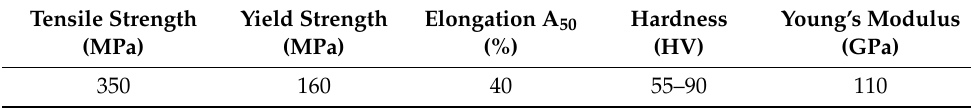
Table 1. Prescribed mechanical properties of brass cone pipe (CuZn 3 O).